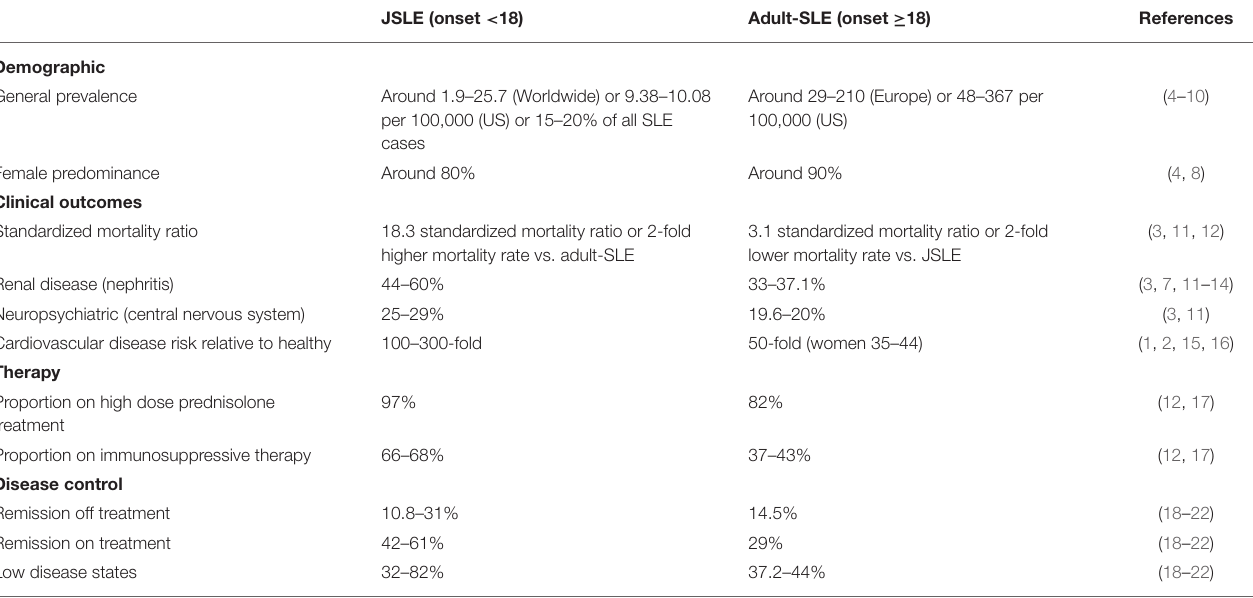
TABLE 1 | Summary of important demographic and clinical characteristics of patients with juvenile-onset compared to adult-onset